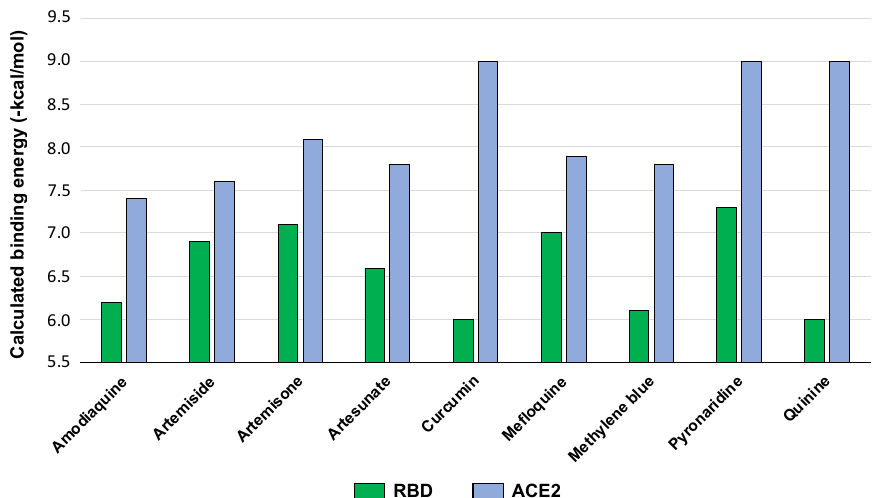
Figure 2. Calculated binding energies for the interaction of the compounds with RBD (PDB ID: 6VSB) and ACE2 (PDB ID: 6LZG).